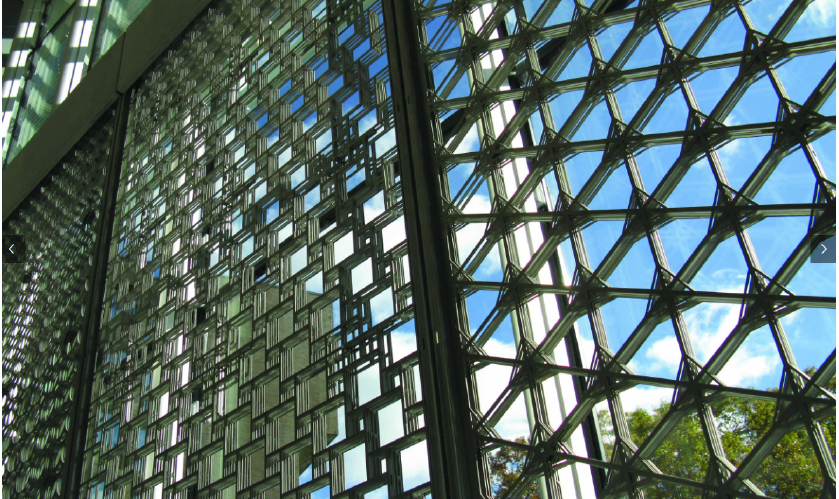
Figure 1. An example of shading devices used as an essential part of a structure for controlling solar radiation is the dynamic windows at the Simon Centre for Geometry and Physics at the State University of New York, USA (2010) (Source: https://www.hoberman.com/portfolio/dynamic-windows/). South Korea’s Thematic Pavilion is also an example of an integrated self-shaded de- vice. It is inspired by a South African flower and has a movable 90-degree flap. The main use of the principle is solar shading with minimized view obstruction when cloudy weather and full protection from the sun when sunny [31]. The Pavilion is based on Stre- litzia Reginae’s movements. The perch curves and the petals open whenever a bird lands